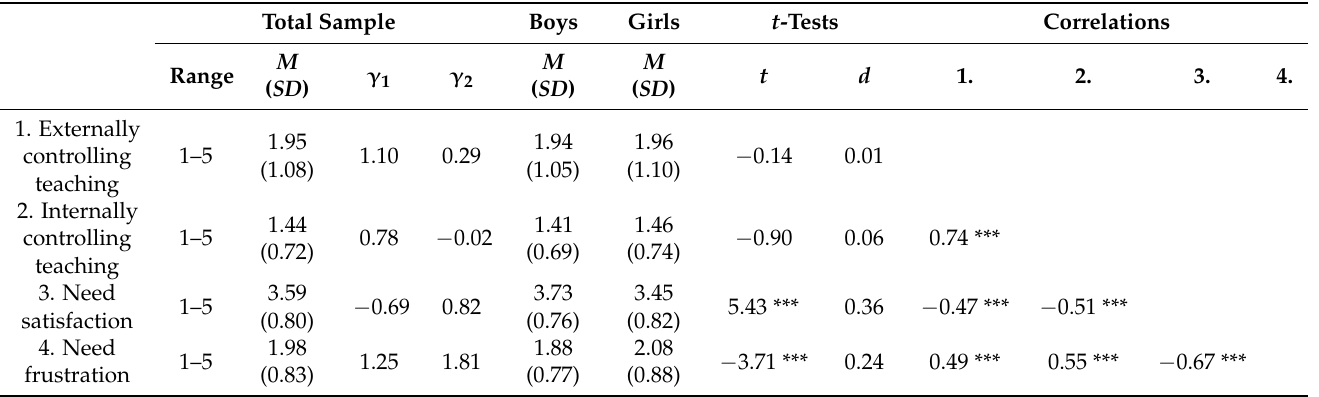
Table 3. Descriptive statistics, gender differences, and correlations among study variables.